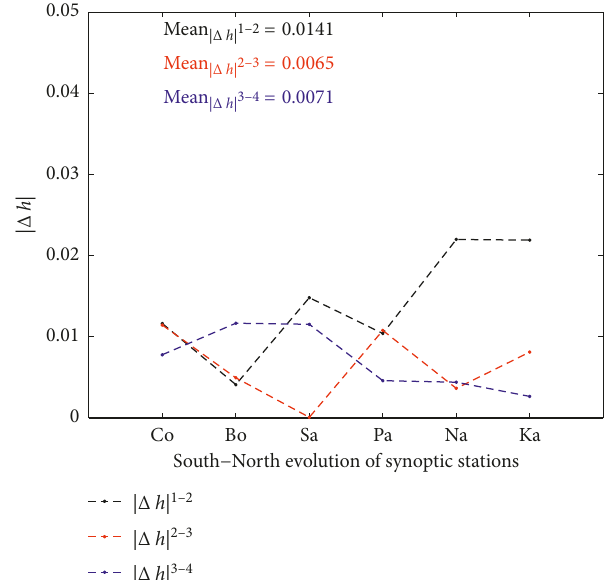
Figure 4: Spatial distribution of Δ h m,m + 1 obtained by the DFA1-4 method ( Δ h m,m + 1 � | h ( DFAm ) − h ( DFAm + 1 )| ). For a DFA m , an m- order polynomial is used to calculate the local trend in each